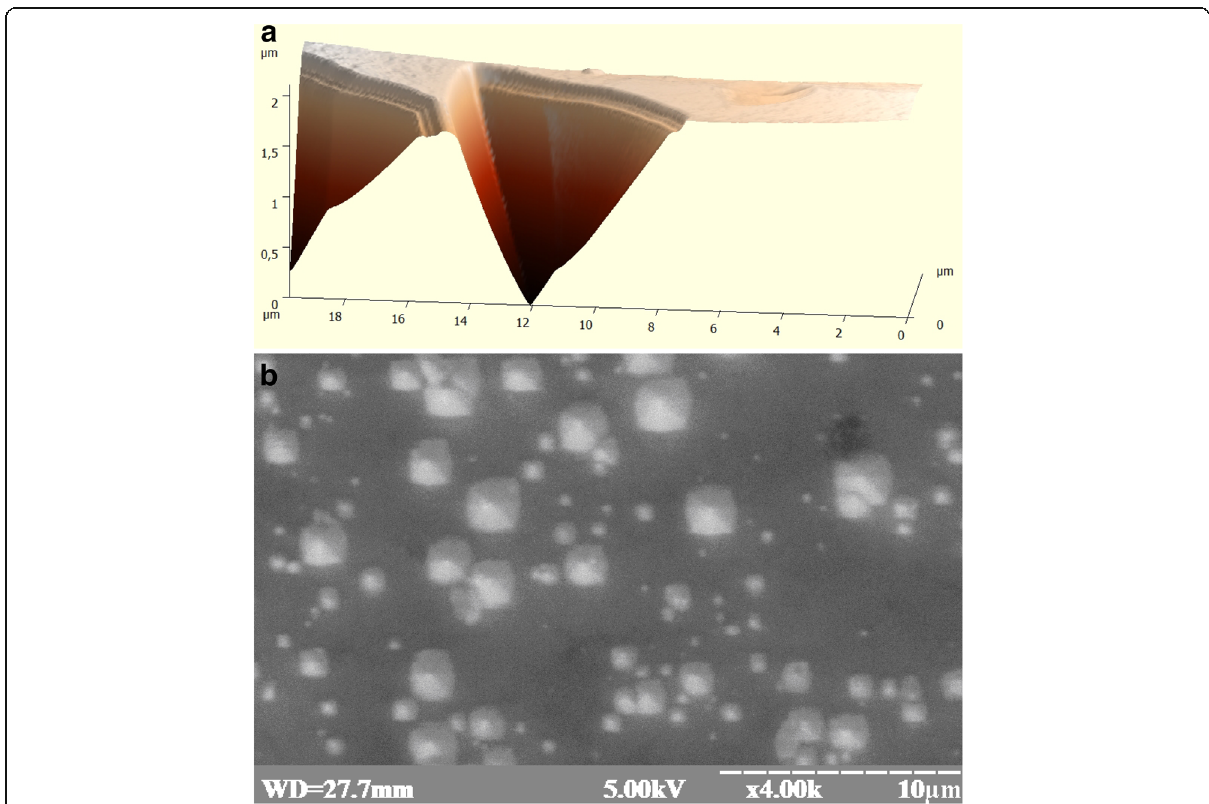
Fig. 1 The appearance of the surface of the experimental samples: a appearance of dislocation etch pits on the surface of the p-Si crystal ob- tained in the field of atomic force microscope and b appearance of submicroscopic surface (111) of solar crystals